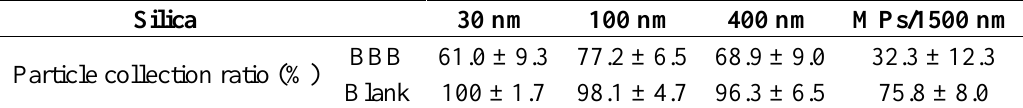
Table 1. Results of particle collection ratio in the BBB assay of silica (1.0